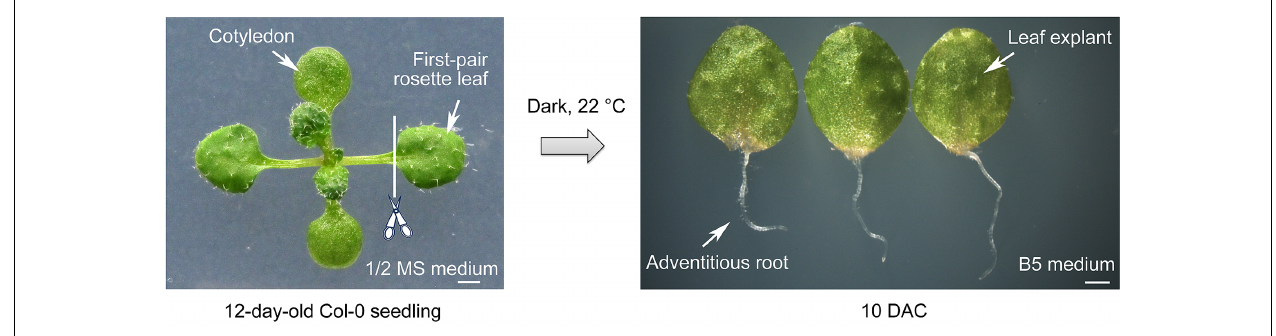
FIGURE 1 | Method for de novo root organogenesis. Scale bar: 1 mm.